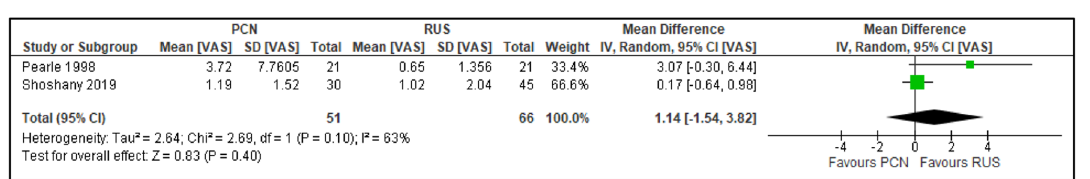
Figure 17. Comparison between PCN and RUS for outcome post-procedural pain (as measured by VAS).